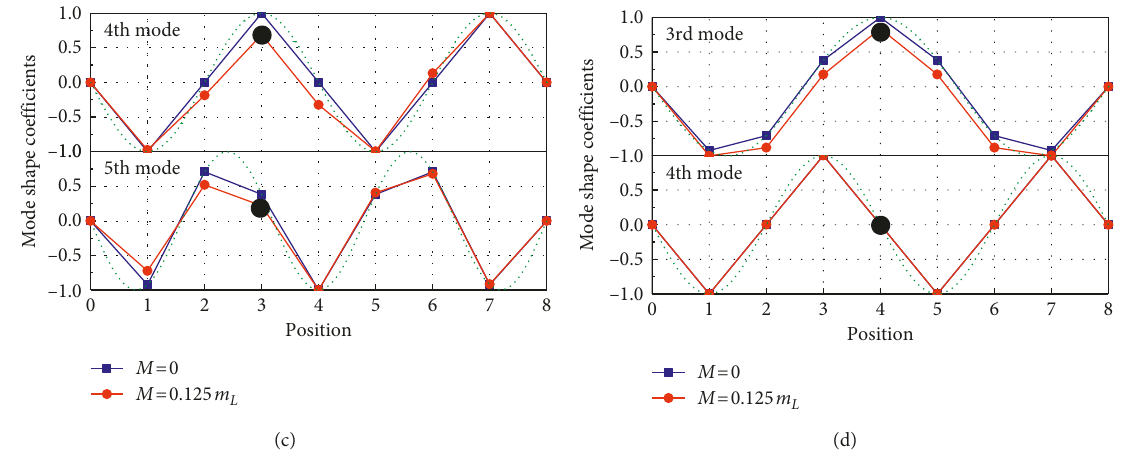
Figure 5: Mode shape variations of the simplified model with 1 additional concentrated mass: (a) 1 concentrated mass on position 1; (b) 1 concentrated mass on position 2; (c) 1 concentrated mass on position 3; and (d) 1 concentrated mass on position 4.